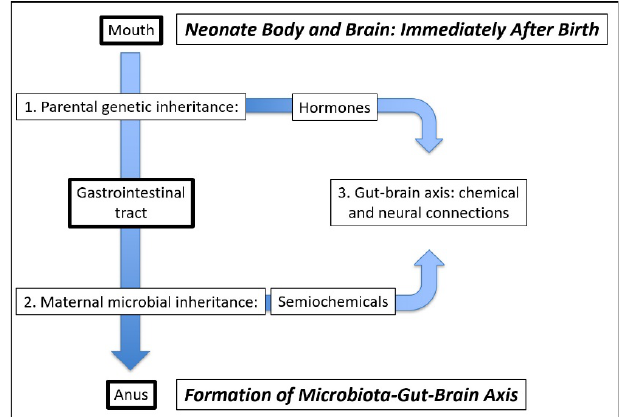
Figure 2. The Role of the Foetal Microbiome in Connecting Microbiota, Gut, and Brain. Box 1 . The foetal gastrointestinal tract (dark border) develops according to its parental genetic inheritance. At the same time, hormones are produced by the endocrine system. Box 2 . The microbiome of the ne- onate is provided by its microbial inheritance from the mother. At the same time, semiochemicals are produced, acting as interkingdom signalling molecules. Box 3 . The combined action of hor- mones and semiochemicals creates and maintains channels of neural and chemical communication between microbiota, gut, and brain.